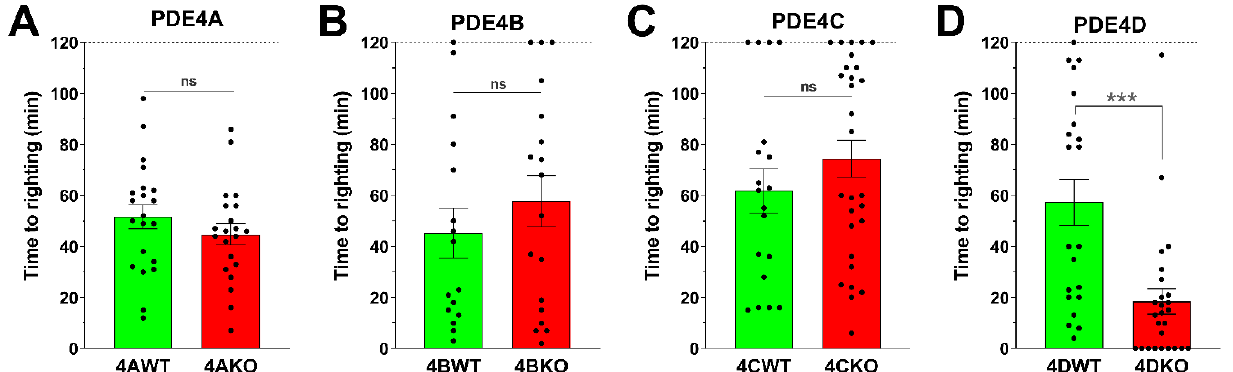
Figure 2. Genetic ablation of PDE4D, but not ablation of PDE4A, PDE4B or PDE4C, shortens the duration of Ketamine/Xylazine-induced anesthesia in mice. Mice deficient in PDE4A ( A ), PDE4B ( B ), PDE4C ( C ), or PDE4D ( D ), and their respective wildtype littermates, were anesthetized with a combination of Ketamine (80 mg/kg) and Xylazine (10 mg/kg) administered by intraperitoneal injection. Upon loss of righting (~3 min), the mice were placed in dorsal recumbency and the time to first righting was measured. Mice that never lost the righting reflex were counted as 0 min. Data represent the mean ± SEM. Statistical significance was determined using the Mann–Whitney test with 95% confidence interval and is indicated as *** ( p < 0.001) or ns (not significant; p > 0.05).